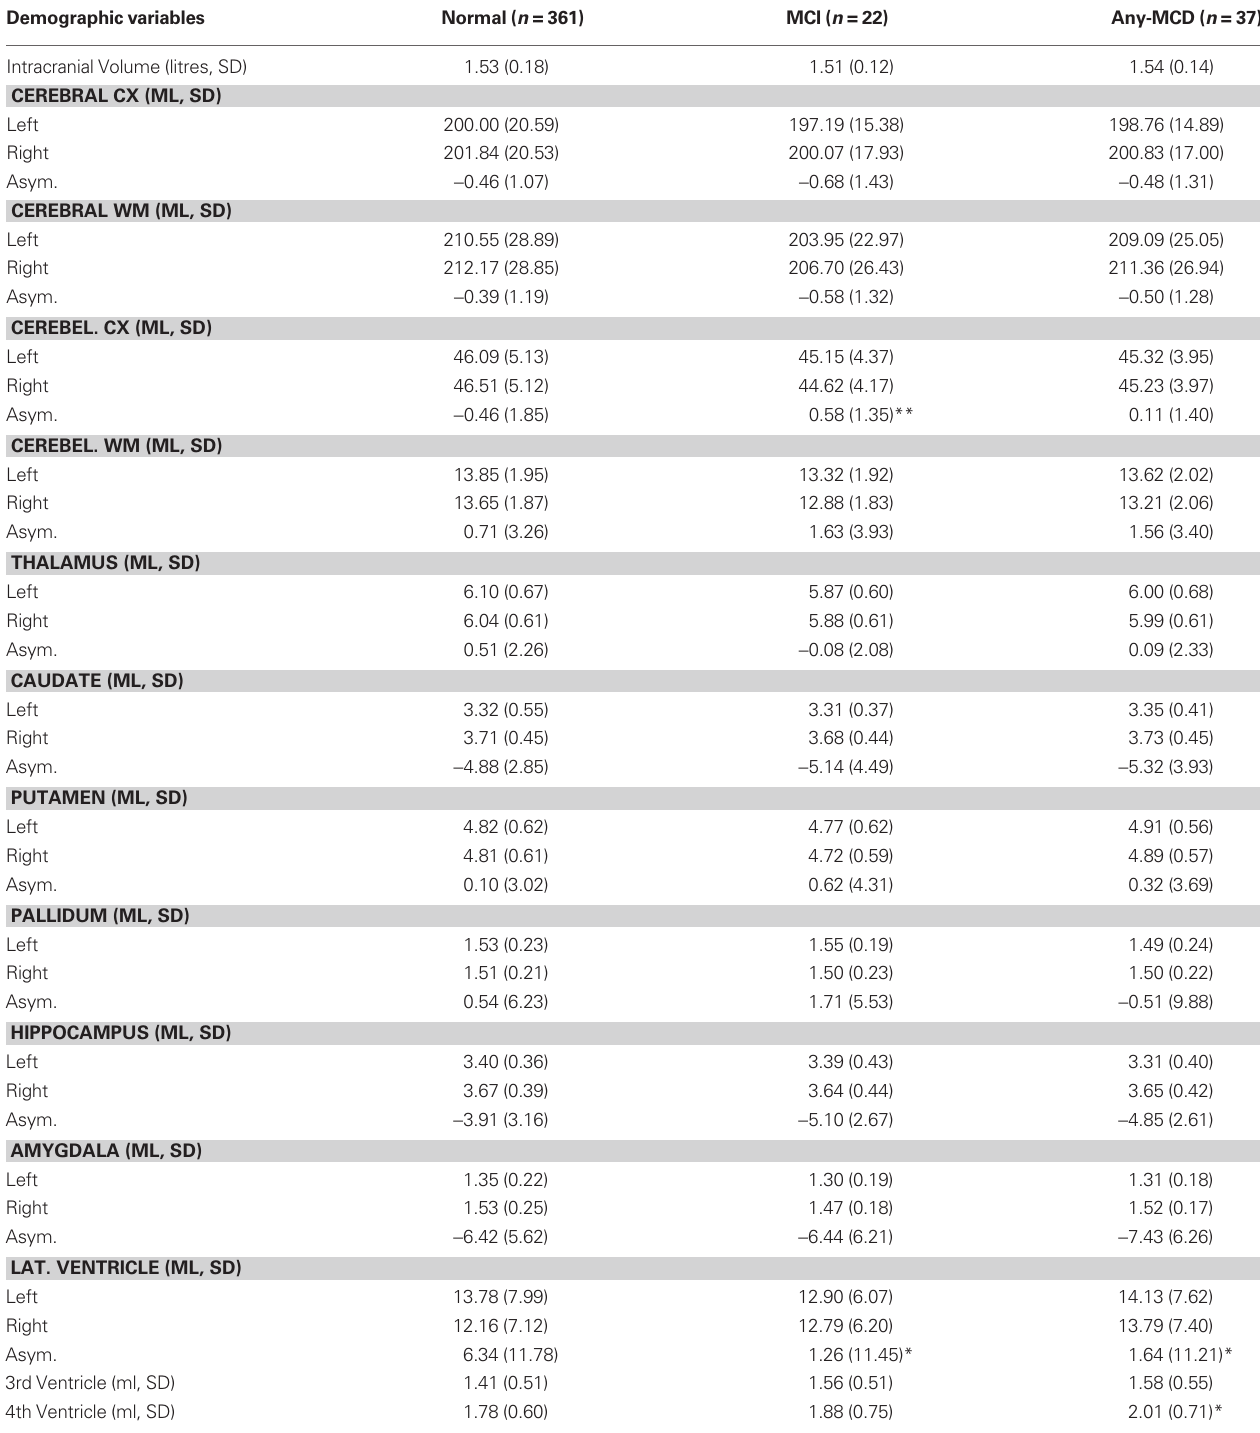
Table 2 | Brain measures of the normal, MCI, and any-MCD